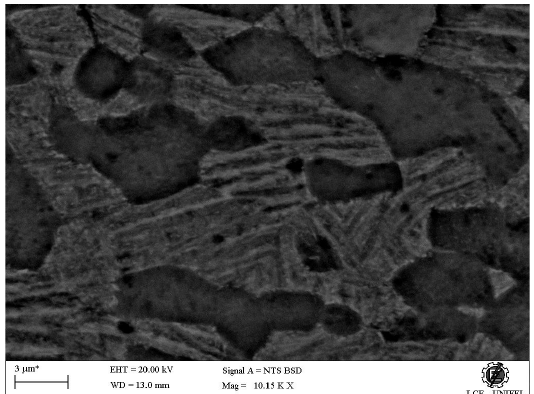
Figure 4. DA Ti-6Al-4V Microstructure.